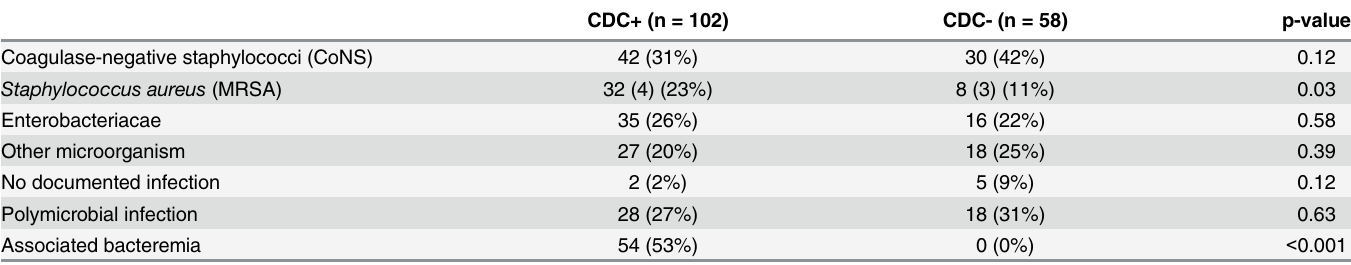
Table 2. Microbiological Data in 160 Patients with Sternal Wound Infection Requiring Reoperation after Cardiac Surgery, n (%). CDC+ (n = 102) CDC- (n = 58)